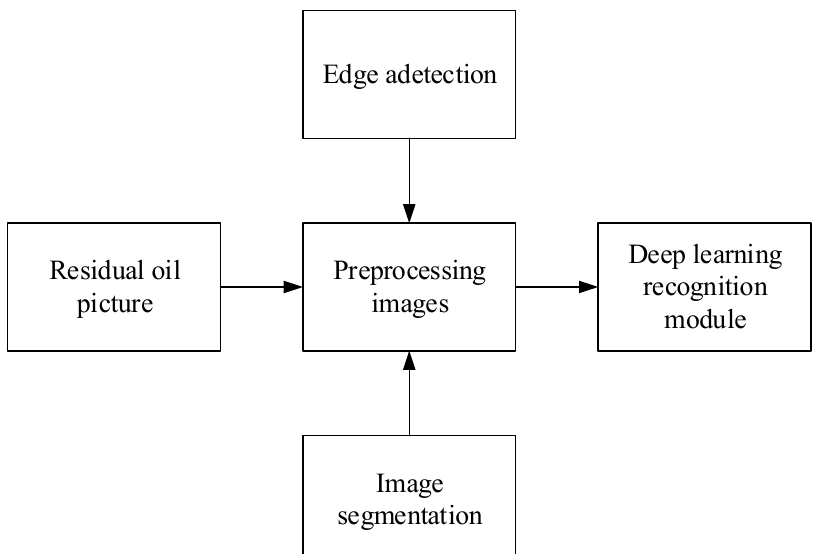
Figure 1. Design diagram of residual oil shape recognition system.